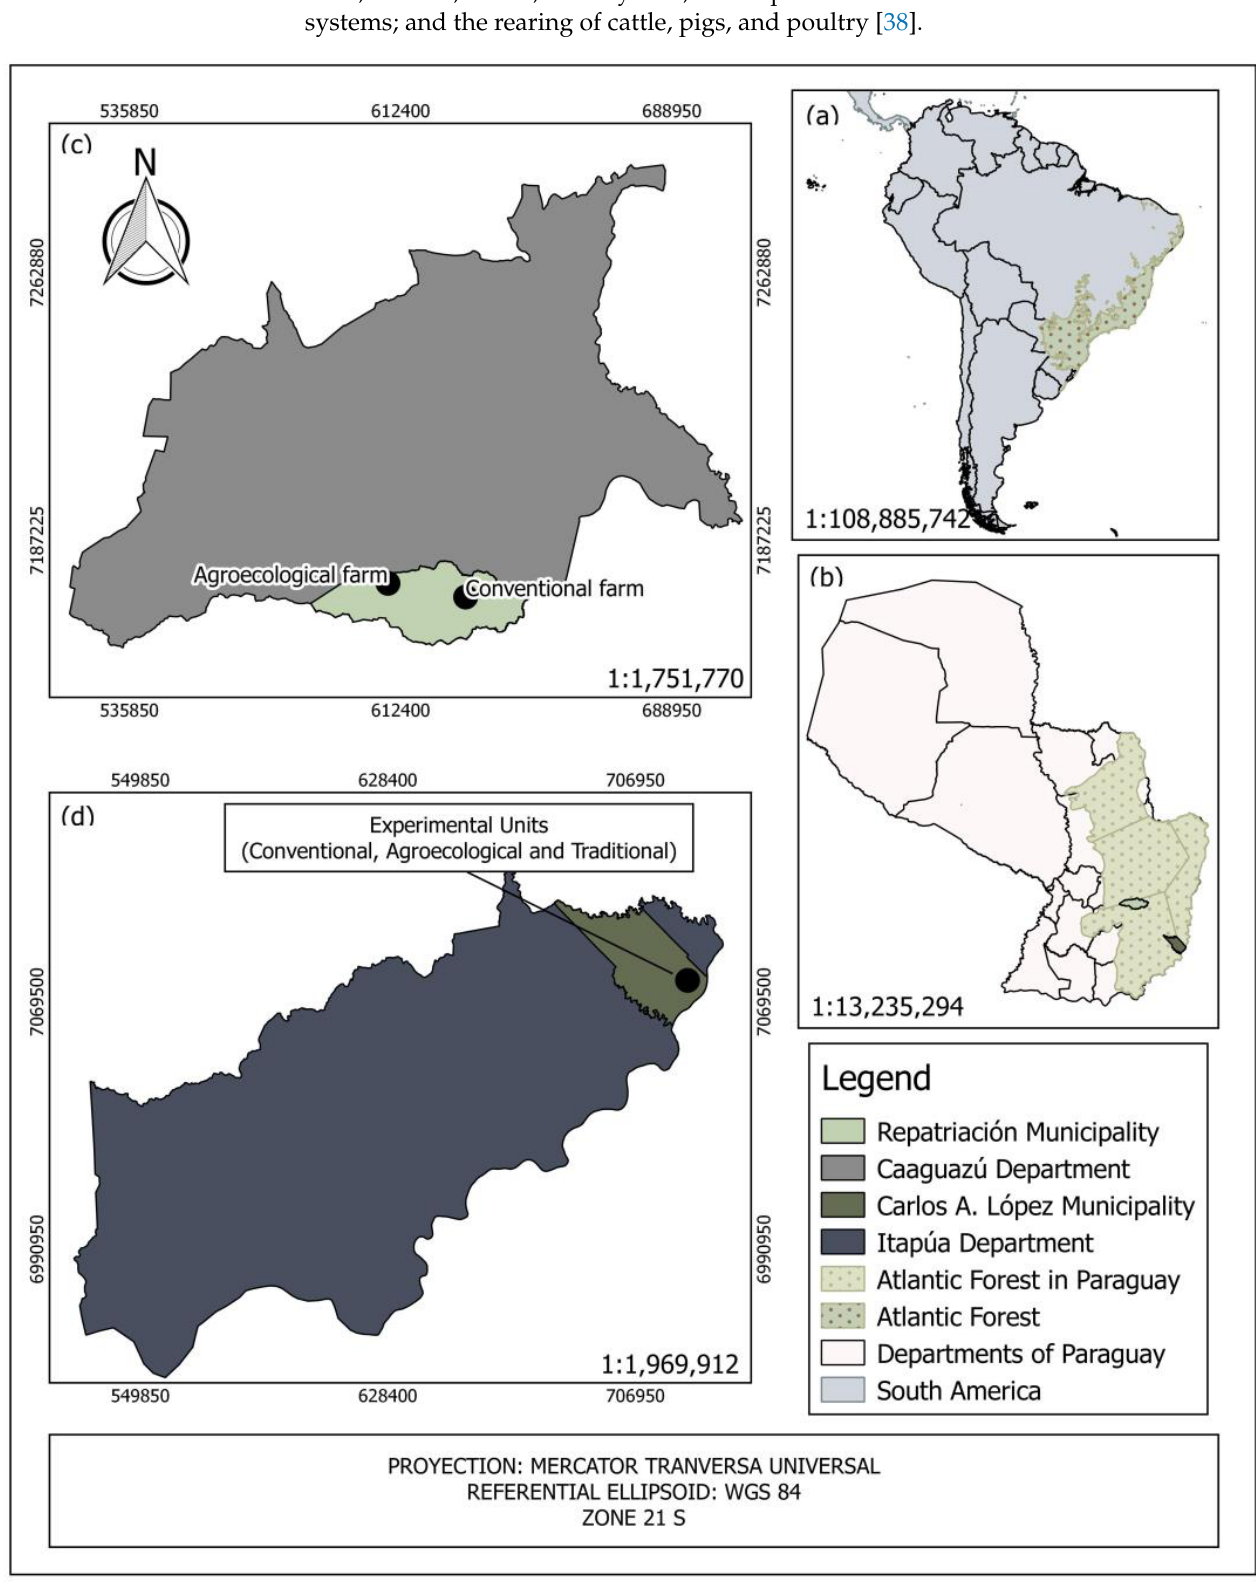
Figure 1. Identification of the study area ( a ) in the Neotropics and ( b ) in the eastern region of Paraguay, and location of the experimental plantations in ( c ) Caaguazú and ( d ) Itapúa. Panels a and b show the distribution area of the Atlantic Forest according to [35].